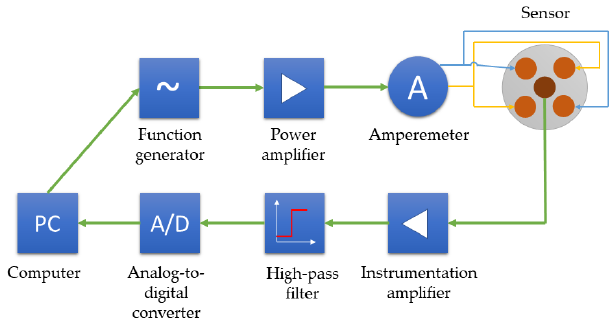
Figure 4. Measuring system.